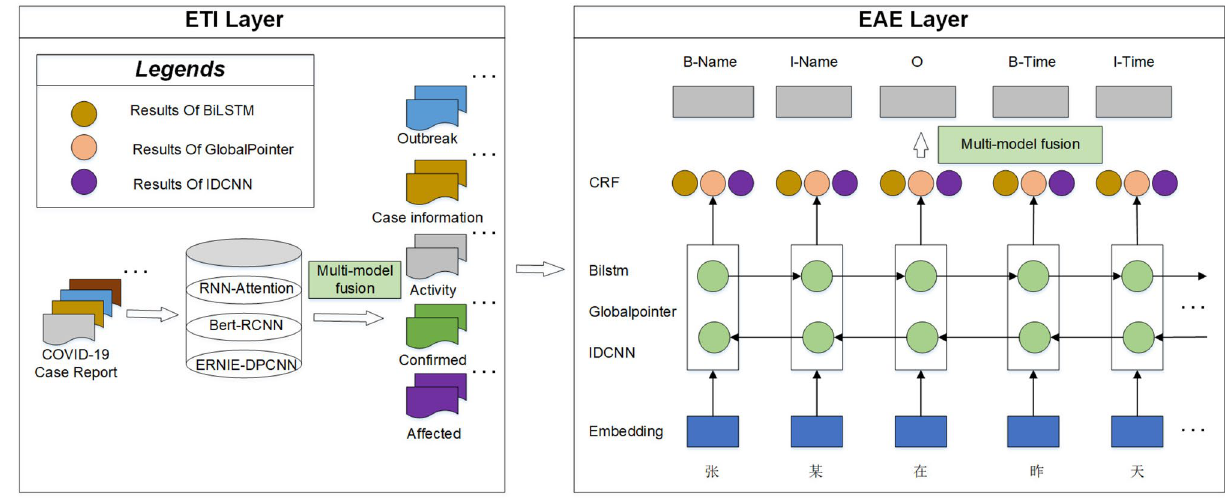
Fig. 3 Overall architecture of